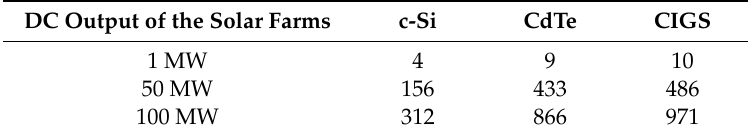
Table 3. The numbers of truck needed to dissemble di ff erent types of PV panels from di ff erent sizes of the solar